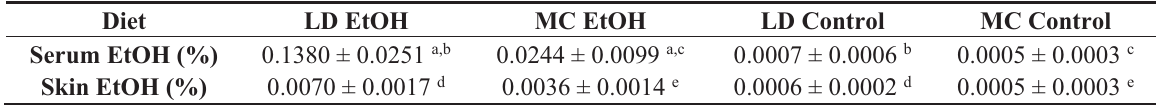
Table 1. Alcohol levels vary